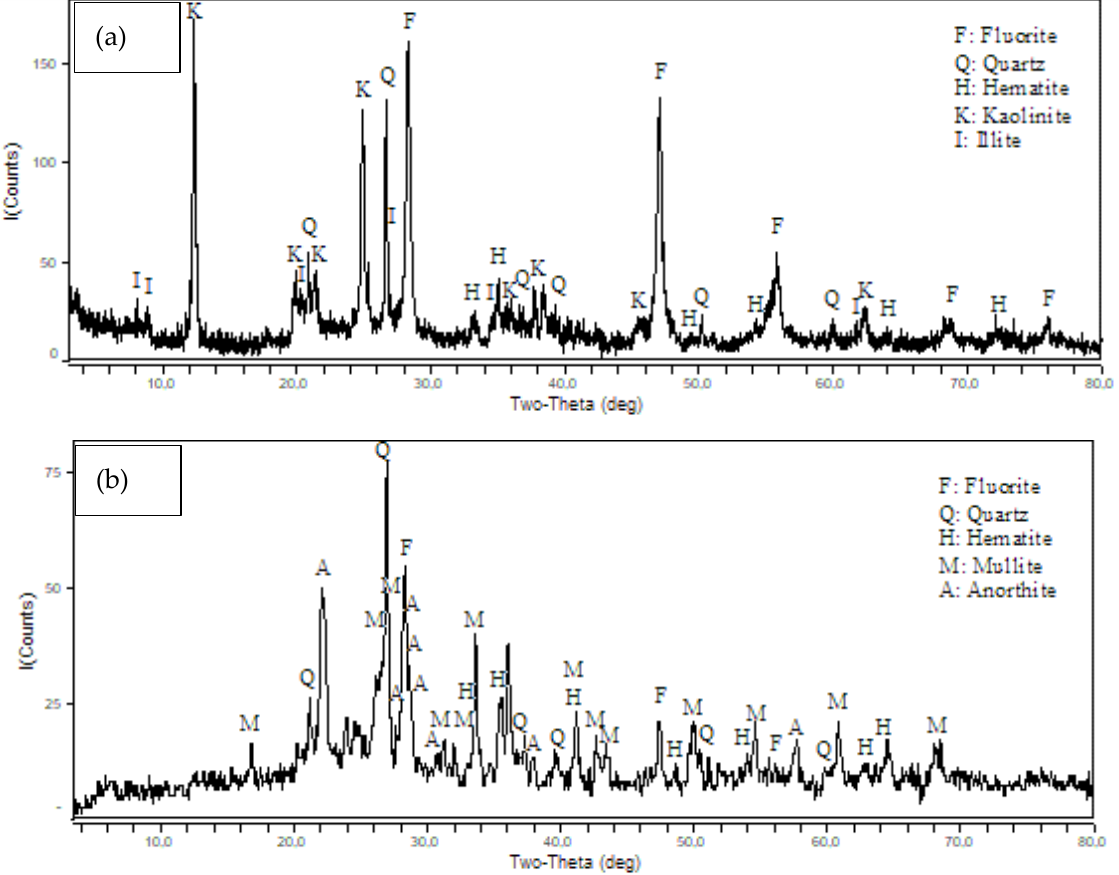
Figure 7. XRD for fabricated membrane: ( a ) without sintering operation and ( b ) with sintering operation at 1000 °C.